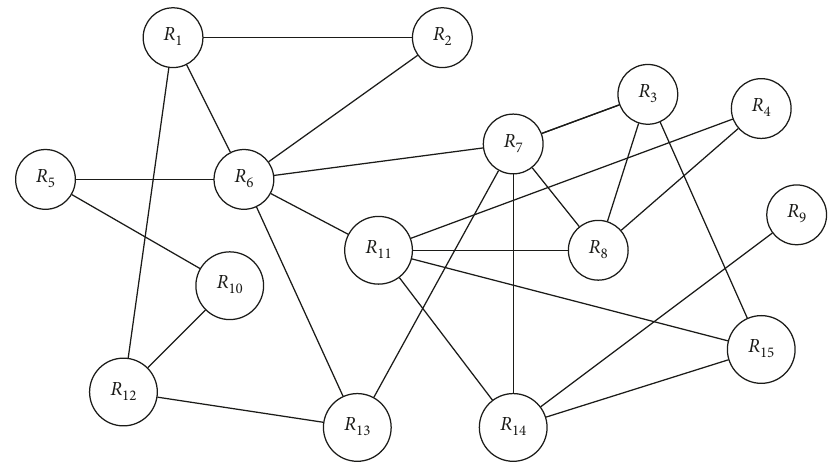
Figure 4: Bipolar-valued fuzzy G-S Research